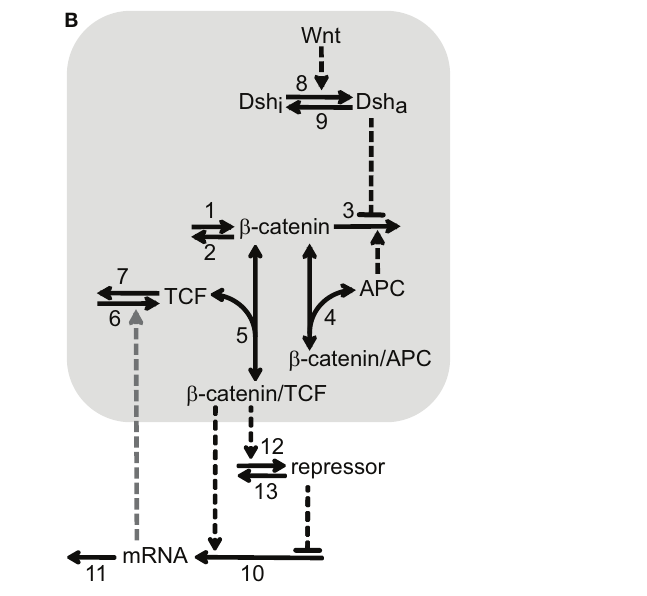
their downstream target gene regulation motif. (A) Direct regulatory mechanisms: the dashed line ending with a dot between β -catenin/TCF complex and reaction 10 indicates that the β -catenin/TCF complex regulates the mRNA production either by a direct activating or repressing mechanism (see Sections “Activation ofWnt/ β -catenin target genes” and “Repression ofWnt/ β -catenin target genes”, respectively). (B) Incoherent feedforward loop: β -catenin/TCF complexes induce the expression of a repressor of the mRNA production, which counteracts the simultaneous direct activation of mRNA expression by β -catenin/TCF complexes in reaction 10, see Section “Wnt/ β -catenin target gene regulation by an incoherent feedforward loop